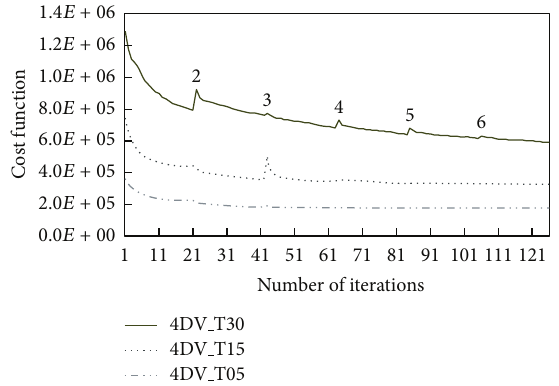
Figure 4: Cost functions with respect to the number of total iterations accumulated by the 6 outer loops indicated on top of the solid curve. The three cost functions are from three experiments that use the assimilation window length of 5 minutes (4DV T05), 15 minutes (4DV T15), and 30 minutes (4DV T30) (from